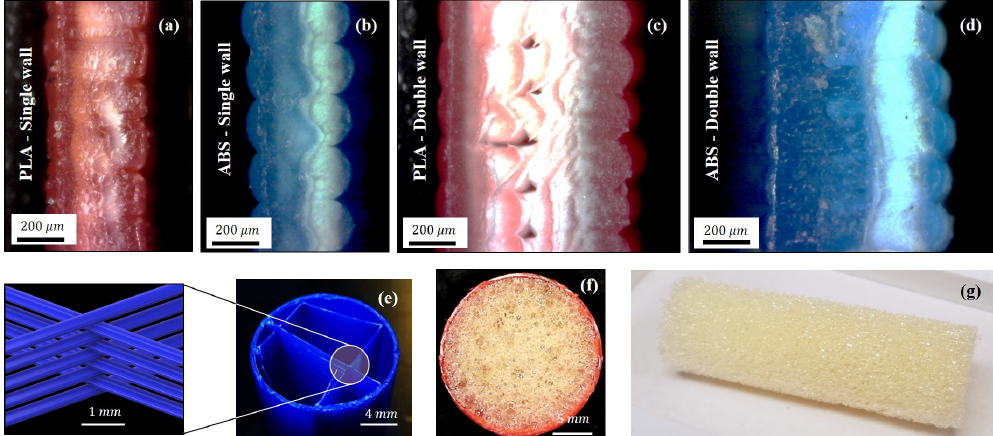
Figure 1. Example mesostructures for the: ( a ) single wall polylactic acid (PLA), ( b ) single wall acrylonitrile butadiene styrene (ABS), ( c ) double wall PLA, and ( d ) double wall ABS. Also shown is the ( e ) soft infill and ( f ) foam reinforcements and ( g ) an example foam core.